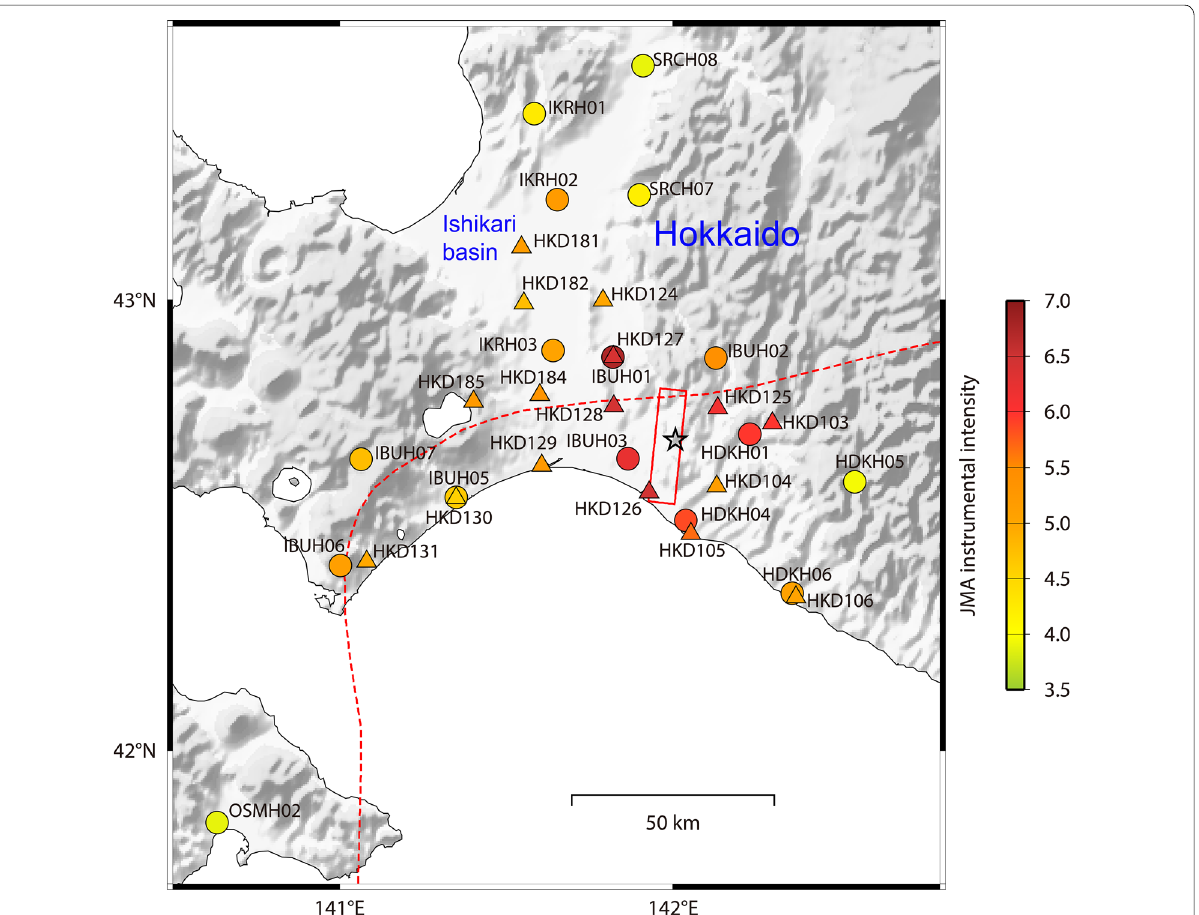
Fig. 3 Location of sites used in the evaluation of nonlinear site response. The K-NET and KiK-net sites are denoted by triangles and circles, respectively. The site codes are written next to the site symbols, which are color-coded by the JMA instrumental intensity. A star denotes epicenter of the mainshock, and rectangle denotes surface projection of the fault plane. A dashed red line denotes volcanic front (see also Fig. 1). See Tables